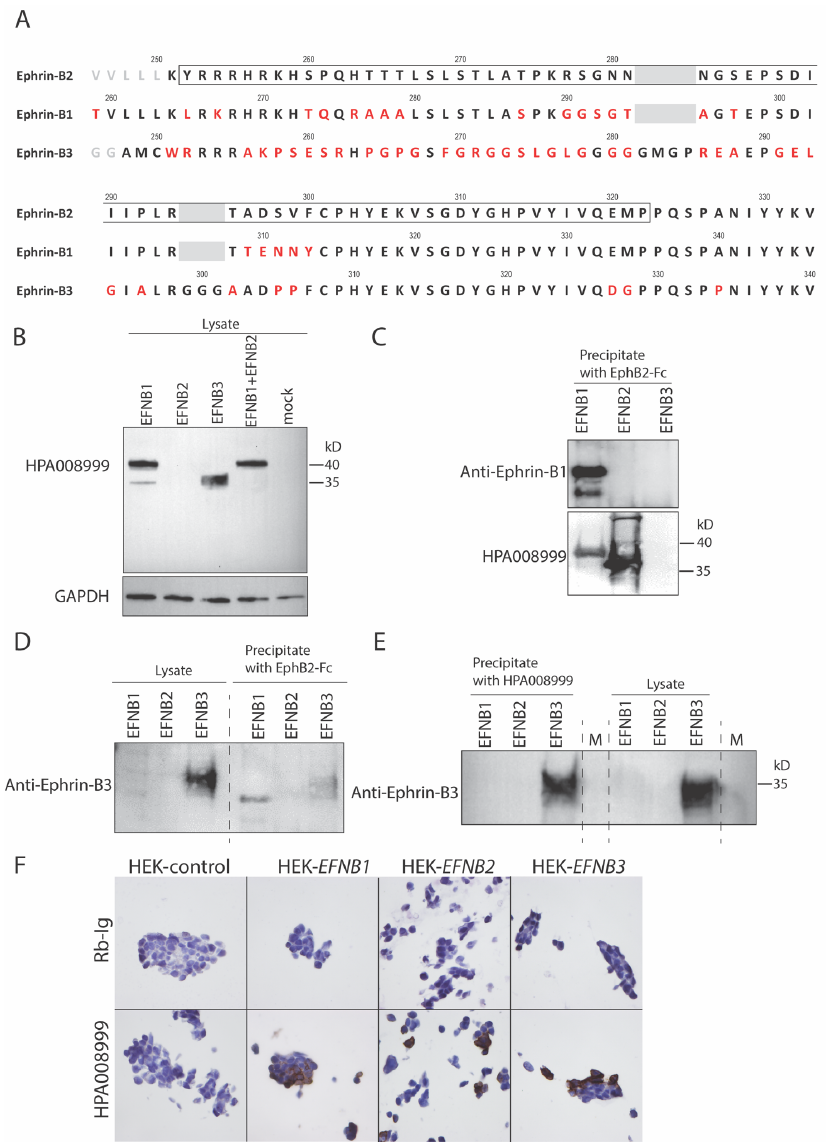
Figure 1. Anti-ephrin-B2 antibody HPA008999 reacted to all ephrin-B members. ( A ) Comparison of amino acid sequences in the intracellular domains of ephrin-B1, ephrin-B2 and ephrin-B3. Boxed area represents the immunogen amino acid sequence for the anti-ephrin-B2 antibody HPA008999. Black letters represent matching, whereas red letters represent non-matching amino acids compared to ephrin-B2. Grey letters represent amino acid outside the intracellular domain. ( B ) HEK-293T cells were transfected with EFNB1 , EFNB2 or EFNB3 alone or co-transfected with EFNB1 and EFNB2 and cell lysates were subjected to Western blot analysis using antibody HPA008999. GAPDH was used as a loading control. ( C ) Ephrin-B1, -B2 or -B3 were transiently expressed in HEK-293T cells and cell lysates were precipitated with EphB2-Fc and separated on SDS-PAGE and blotted. Blots were probed with HPA008999 antibody. ( D ) Ephrin-B1, -B2 or -B3 were transiently expressed in HEK- 293T cells and cell lysates alone or after precipitation with EphB2-Fc were separated on SDS-PAGE and blotted. Blots were probed with an anti-Ephrin-B3 antibody. ( E ) Ephrin-B1, -B2 or -B3 were transiently expressed in HEK-293T cells and cell lysates alone or after precipitation with HPA008999 antibody, were separated on SDS-PAGE and blotted. Blots were probed with an anti-Ephrin-B3 antibody. ( F ) Representative images demonstrating strong membranous/cytoplasmic staining in HEK-293T cells transfected with EFNB1 , EFNB2 or EFNB3 using HPA008999 antibody as compared to untransfected HEK-293T cells. No staining was observed in isotype